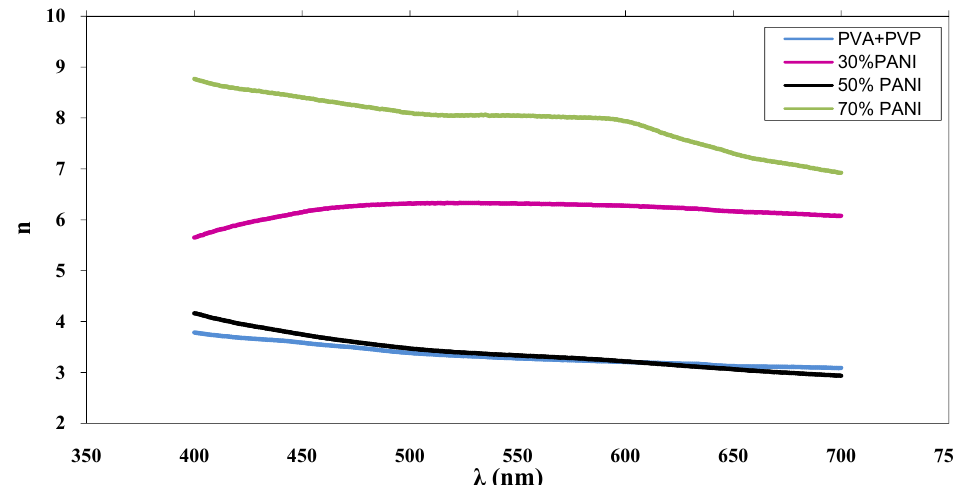
Fig. 5: The refractive index vs. wave length (nm) for (PVA-PVP) +PANI blends polymer.